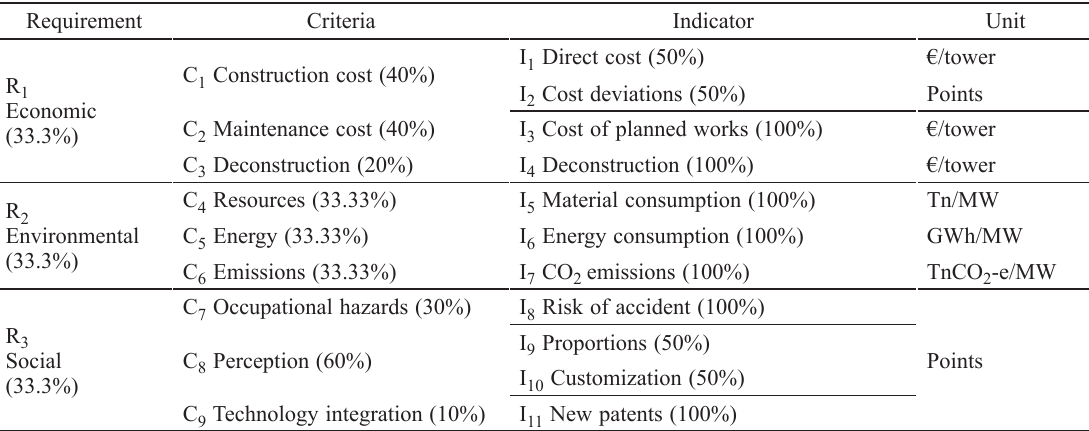
Table 3. Requirements tree